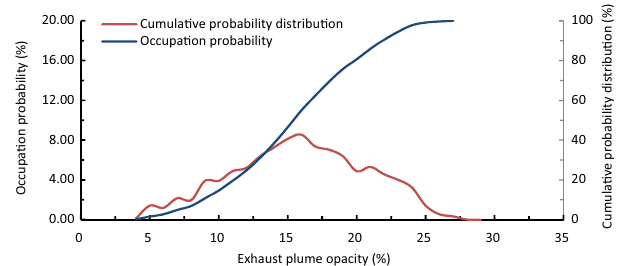
Figure 5. Probability distribution and cumulative distribution probability of RS exhaust opacities of light-duty diesel vehicles in Bin5.